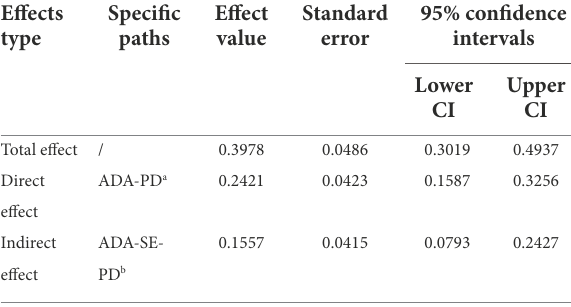
a Algorithmic decision autonomy—purchase decisions. b Algorithmic decision autonomy—self-efficacy—purchase